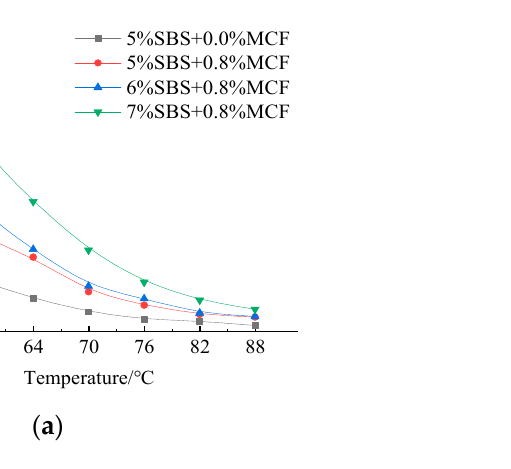
Figure 4. Rutting factors for different modified asphalts. ( a ) Rutting factors for the modified asphalts with different SBS content; ( b ) Rutting factors for modified asphalts with different MCF content.